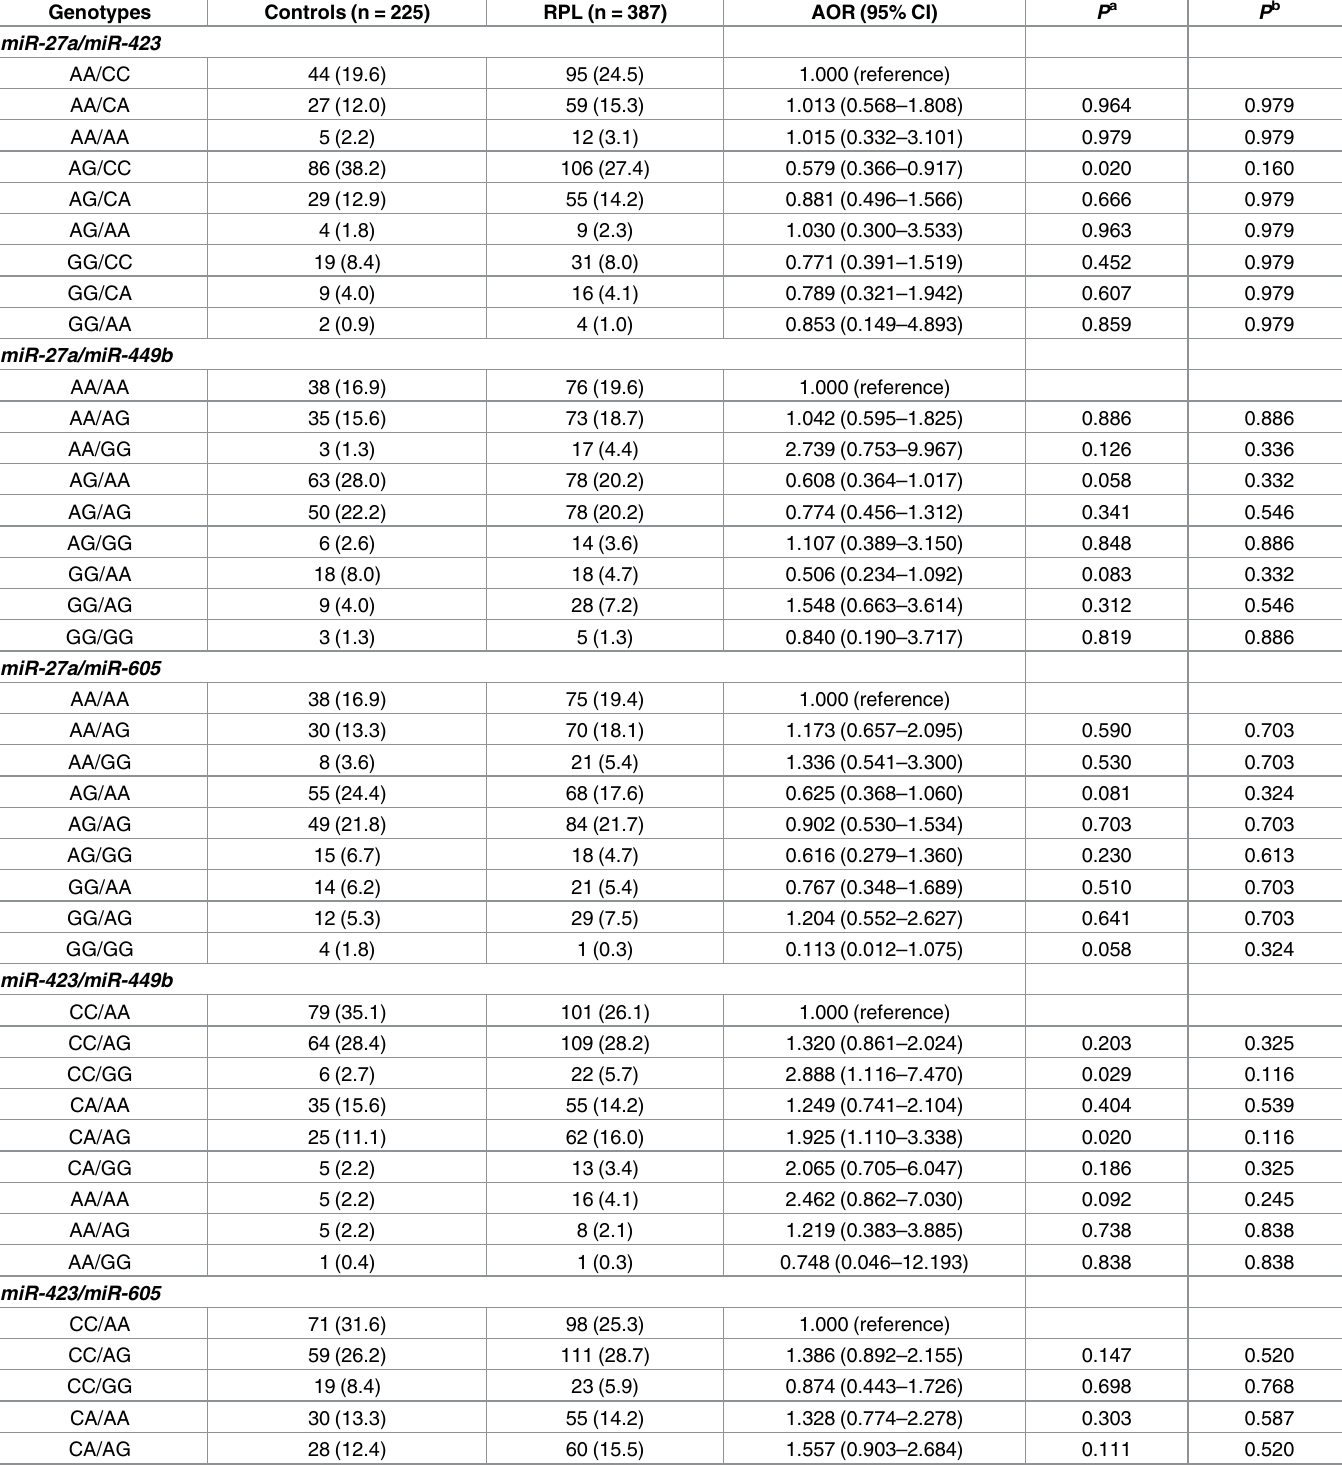
Table 3. Combination analysesof miR-27a A > G, miR-423 C > A, miR-499b A > G, and miR-605 A > G polymorphisms in Korean RPL patients and control